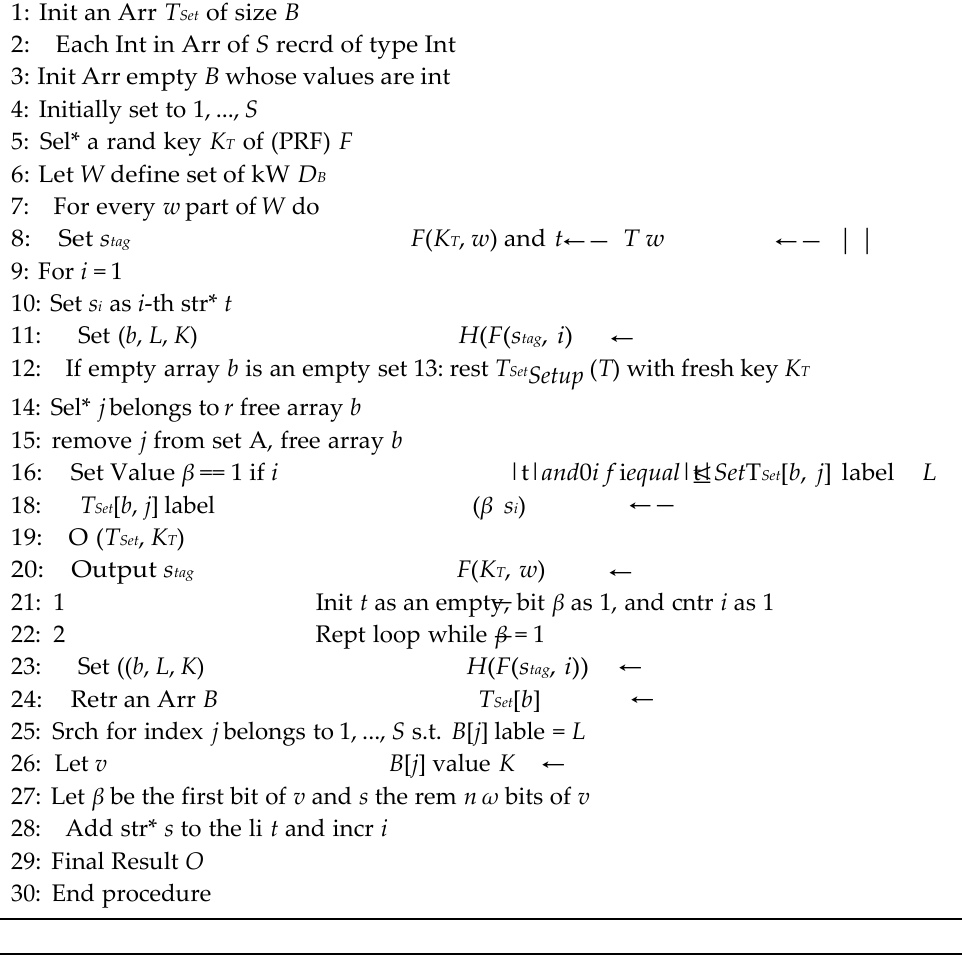
Algorithm 1 Algorithm Transaction Creation and Encryption